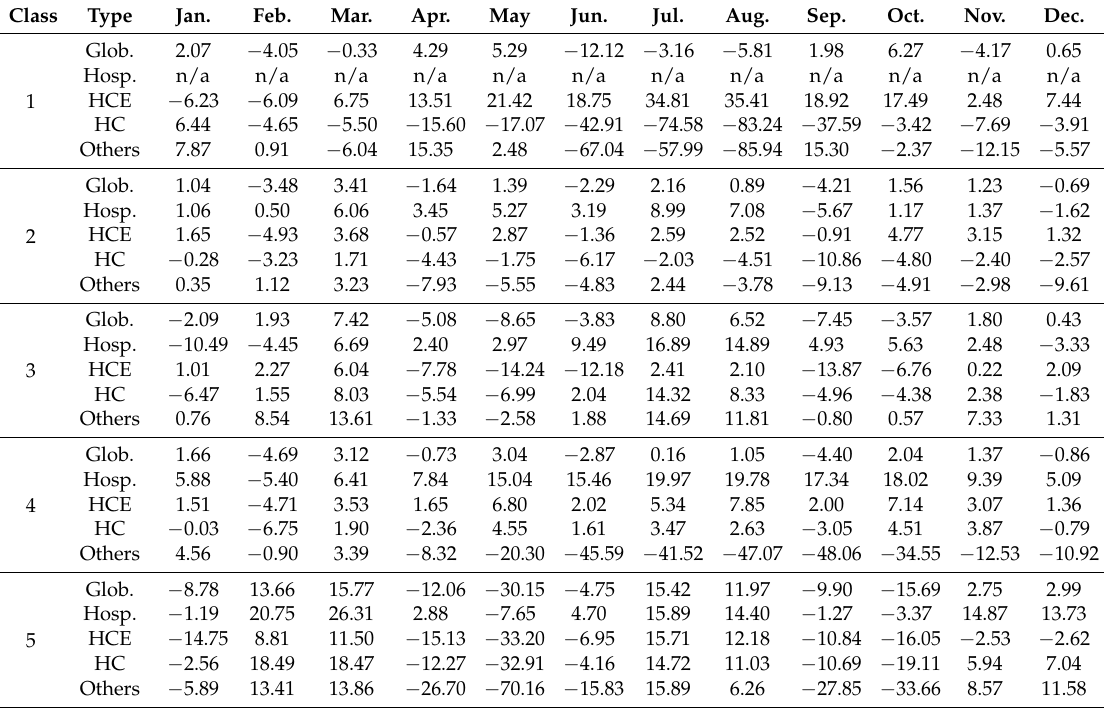
Table 8. Relative error for the average relative ACI values (%) for each class and building type.